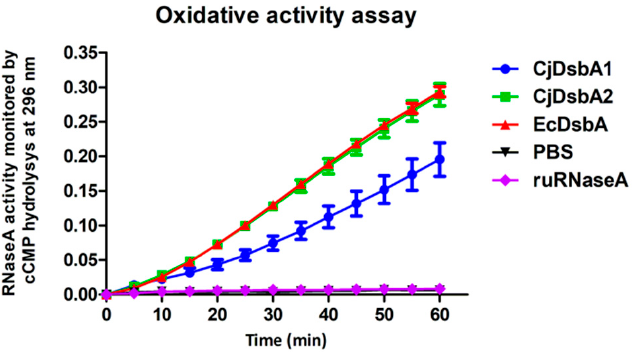
Figure 1. In vitro oxidase activity of CjDsbA2 was comparable to EcDsbA, but CjDsbA1 was less active in oxidative activity assay with unfolded reduced RNaseA (ruRNaseA). Purified EcDsbA was used as a control. Reactions were carried out in 200 µ L of PBS buffer containing 100 mM Tris acetate pH 8.0, 2 mM EDTA, 0.2 mM GSSG, 1 mM GSH, 4.5 mM cCMP, ruRNaseA (10 µ M) and the analyzed enzymes (20 µ M). Changes in absorbance at 296 nm as a function of time were measured. The figure presents an average of three independent experiments, each in two technical replicates (with standard deviation error bars). Table 1. CjDsbAs biochemical features.